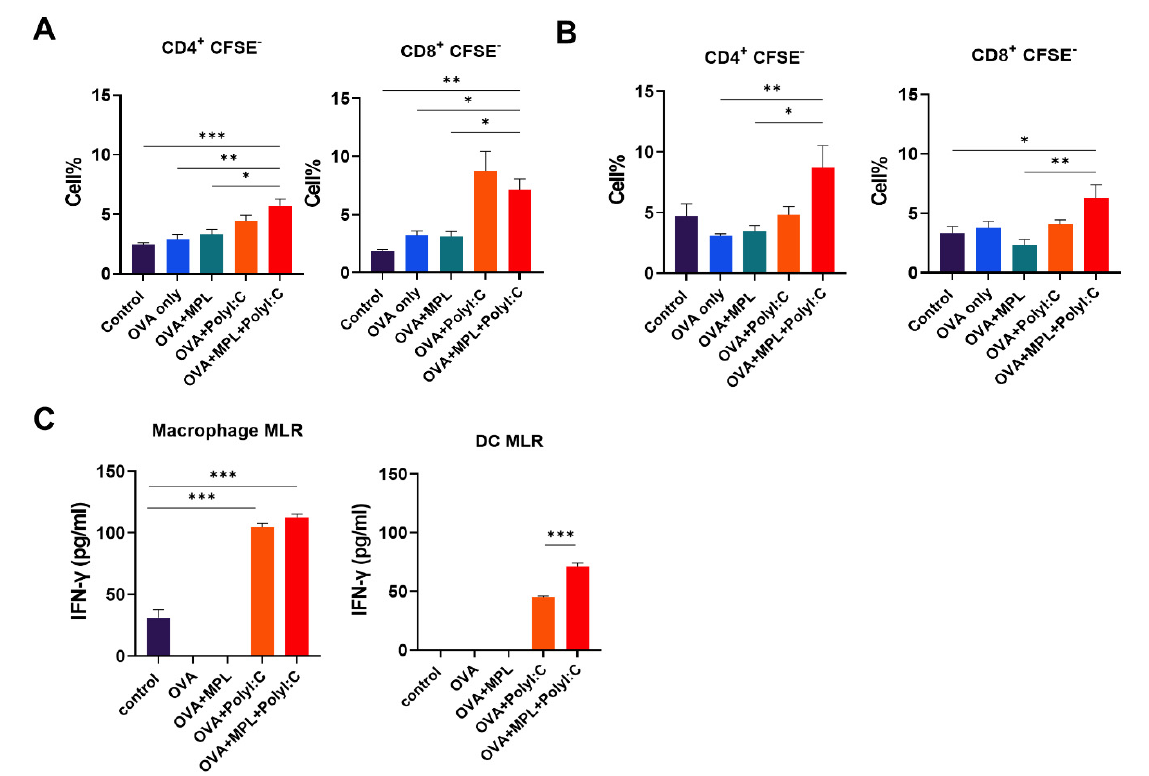
Figure 6. Antigen-specific memory T cell proliferation and cytokine production. Lung ( A ) and spleen ( B ) cells were harvested from the immunized mice 2 weeks after boost immunization. CFSE-labeled cells were cultured with OVA peptide for 5 days and T cell proliferation was determined by flow cytometry. ( C ) The spleen cells from the immunized mice were harvested at 2 weeks post-boost immunization and co-cultured with OVA pre-loaded macrophages or DCs for 5 days. IFN- γ secretion was measured by ELISA. All results were shown in mean ± SEM. For statis-tical analysis, One-way ANOVA and Tukey’s post-multiple comparison tests were performed. * p < 0.05; ** p < 0.01; and *** p < 0.001 between the indicated groups.